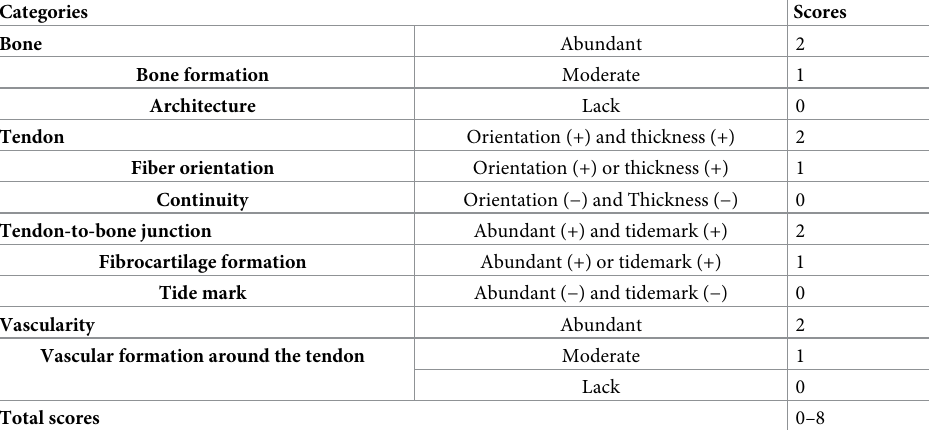
Table 2. Histological scoring system at the tendon-to-bone location.